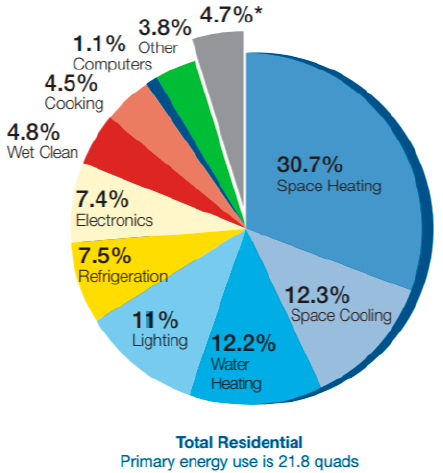
Figure 2. Residential primary energy end-use in the USA 2005 [34].